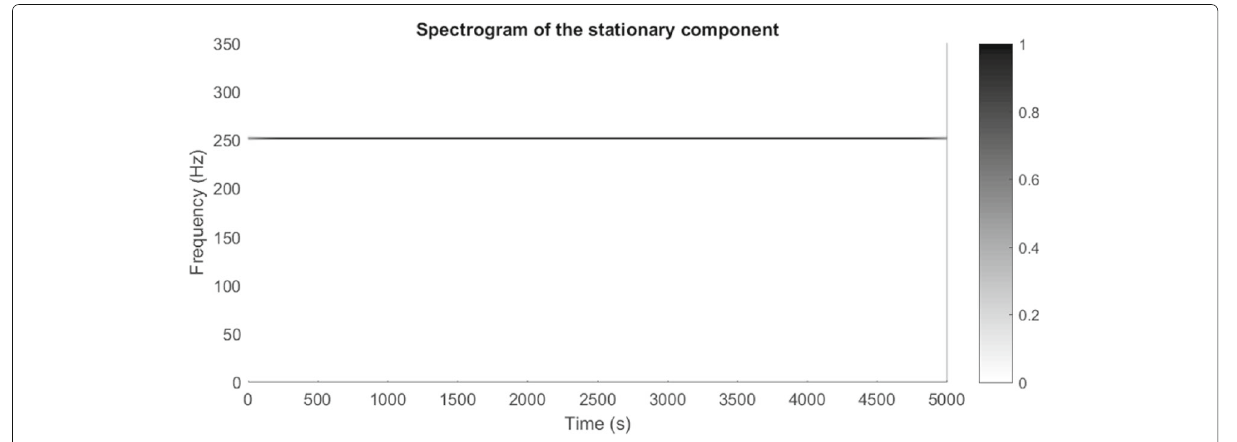
Fig. 6 Synthetic component added around 250 Hz